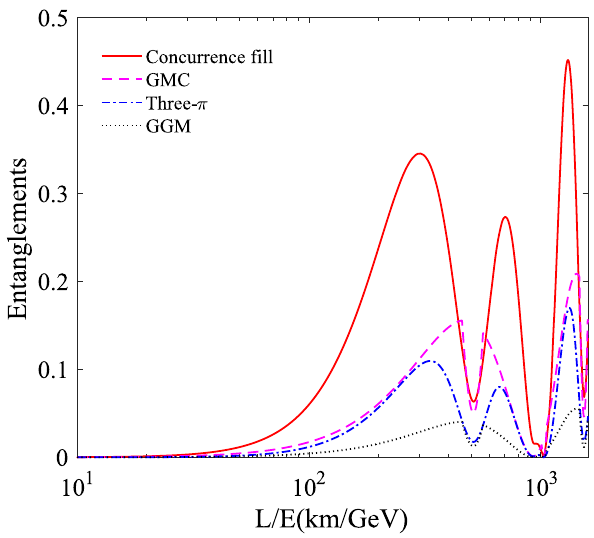
Fig. 5 In the muon antineutrino oscillation system, the multipartite entanglement measured by GGM (black dotted line), three- π (blue, dashed-dotted line), GMC (purple, dashed line), and concurrence fill (red, solid line)